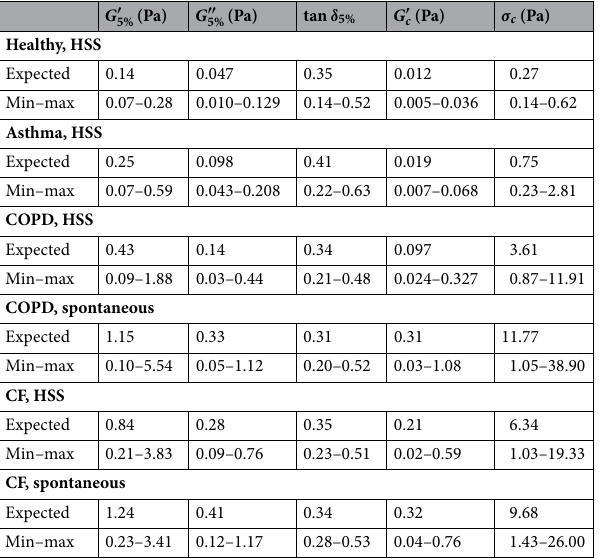
Table 2. Expected and extreme values obtained from the distributions for each rheological quantity measured.